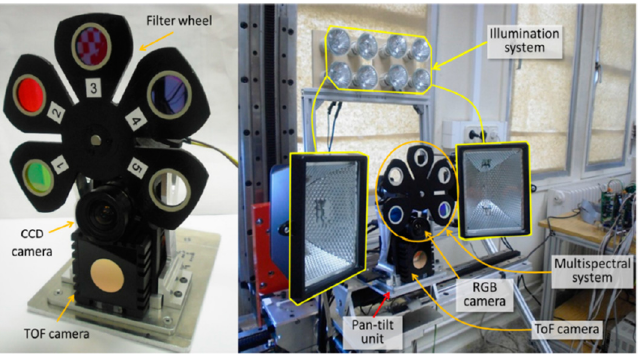
Figure 6. Multisensory system for fruit harvesting (Photo: Reprinted with permission from Ref. [60]. 2014, Fernández R.). Some representative green fruit spectral image acquisition units are listed in Table 2. Table 2. Visual unit for fruits in the similar-colored background.